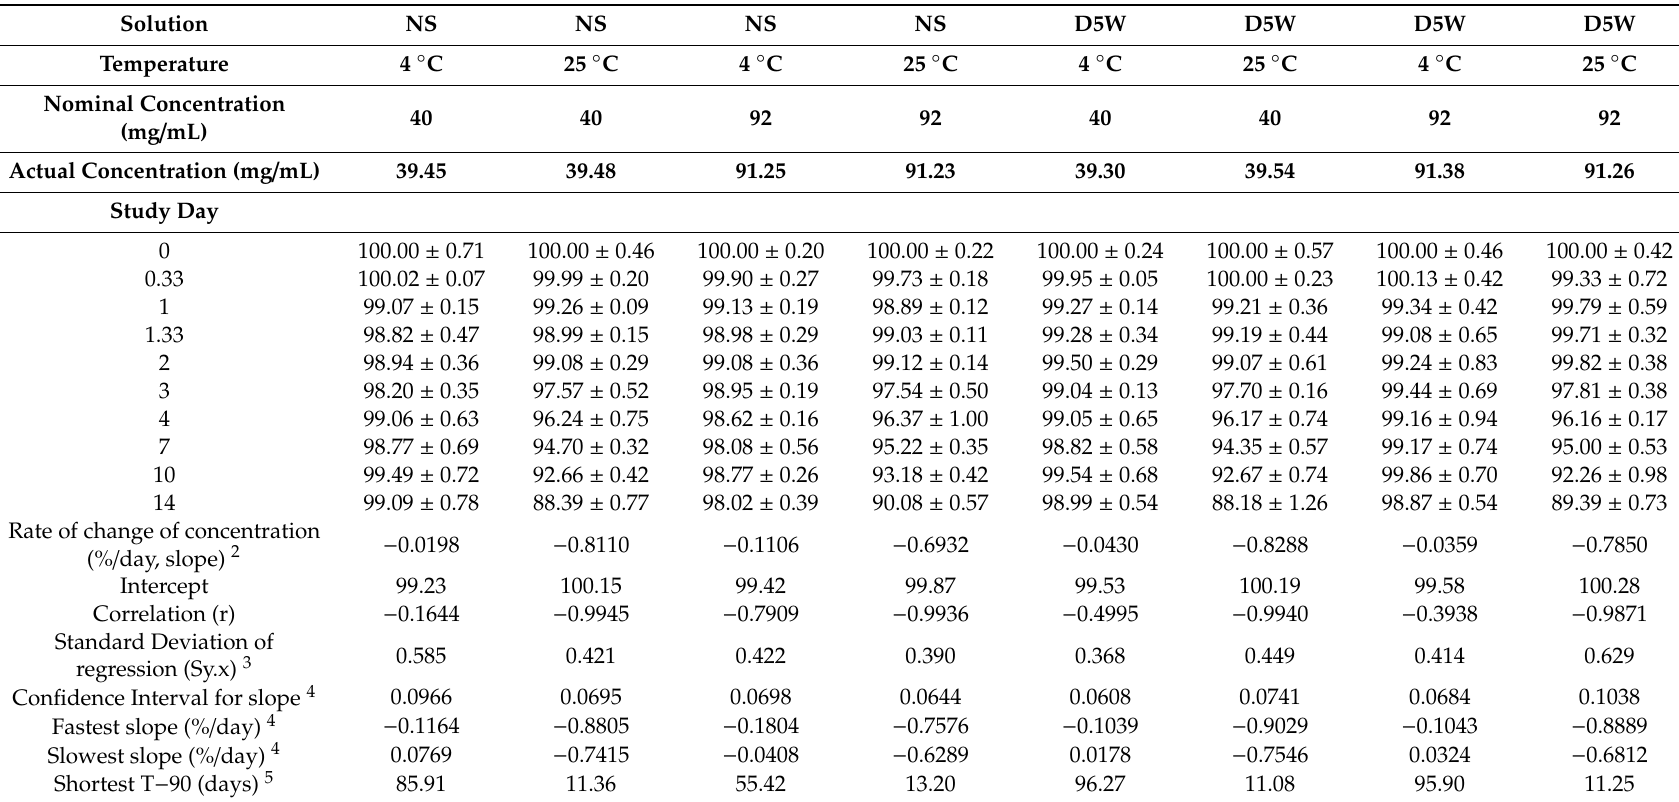
Table 2. Ascorbic acid (Source: Mylan) initial concentrations and percentage remaining 1 on each study day with calculation of the time to achieve 90% remaining (T-90) with 95%